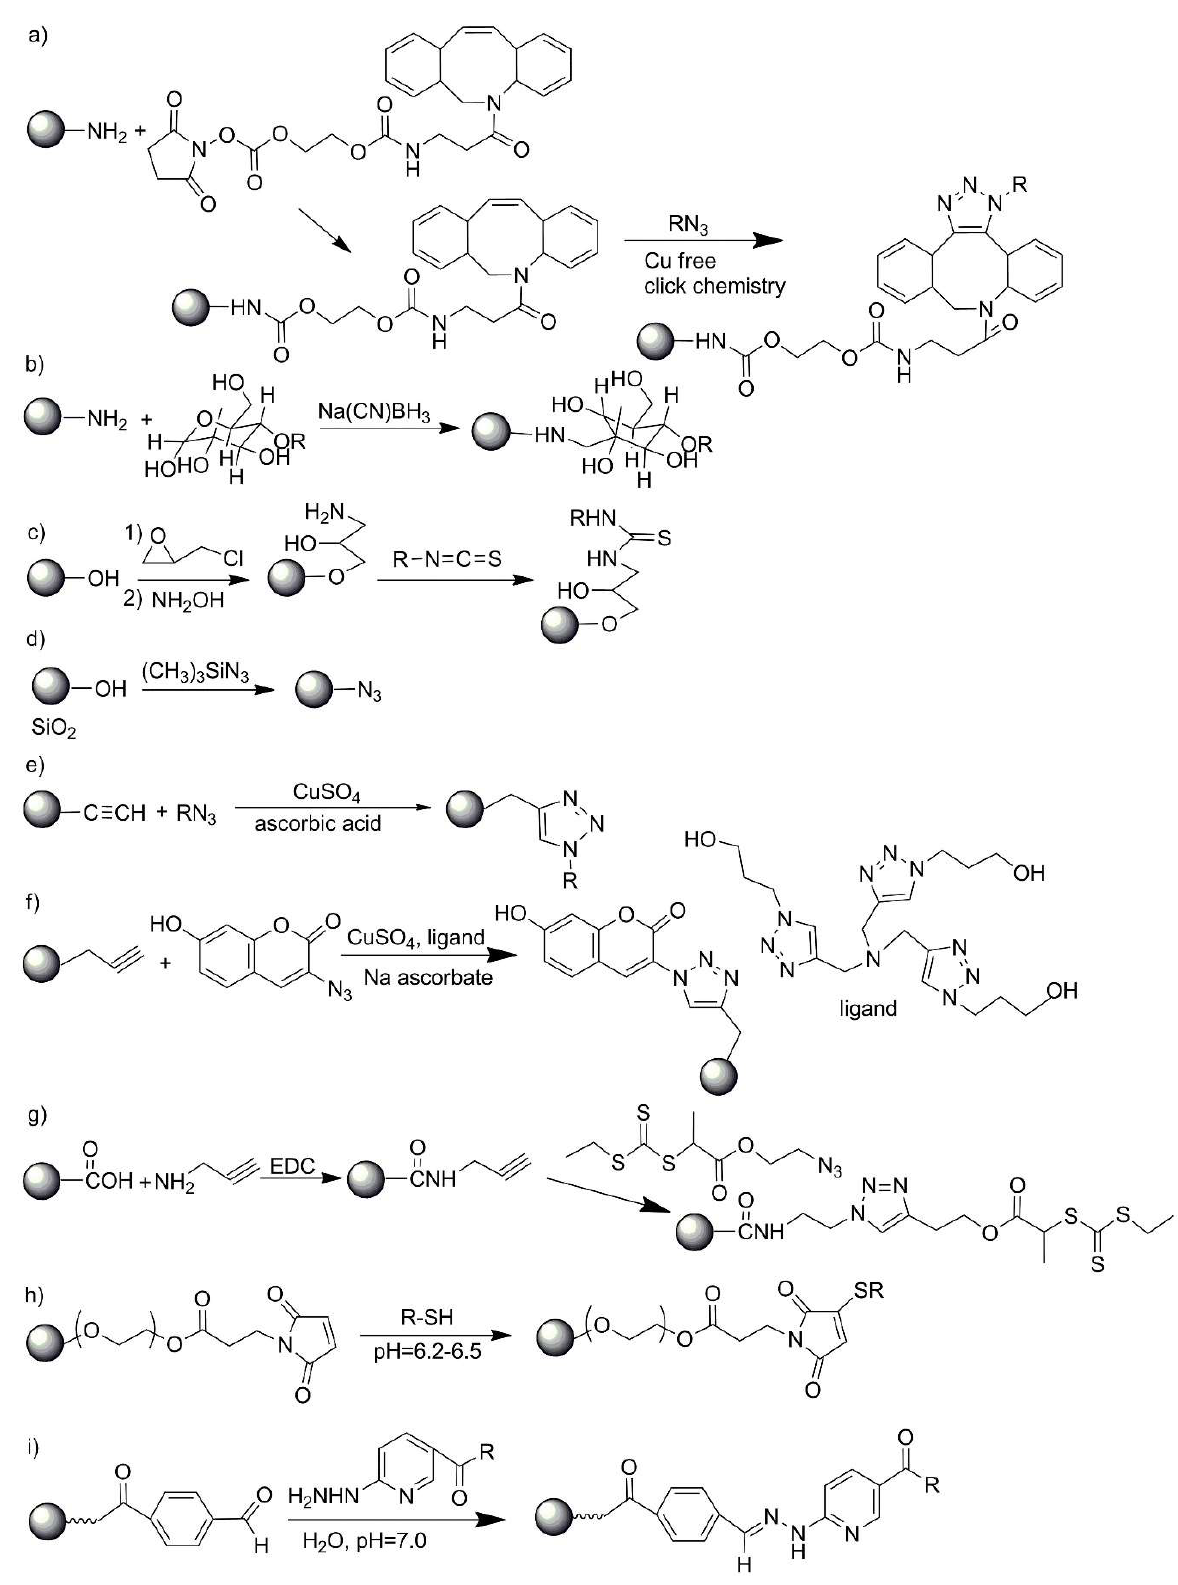
Scheme 30. Reactions used for replacement of functional groups on surfaces of particles. Reaction conditions are pro-